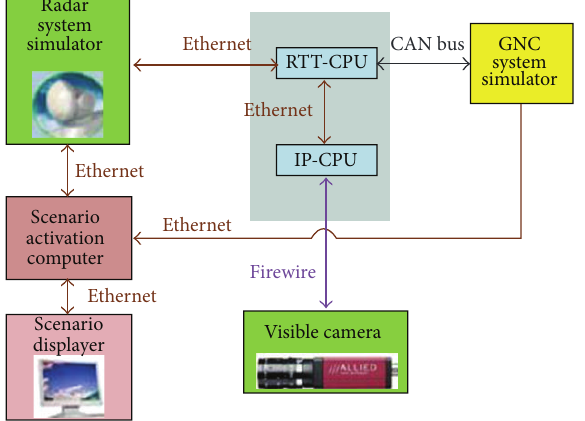
Figure 2: Hardware-in-the-loop system architecture.